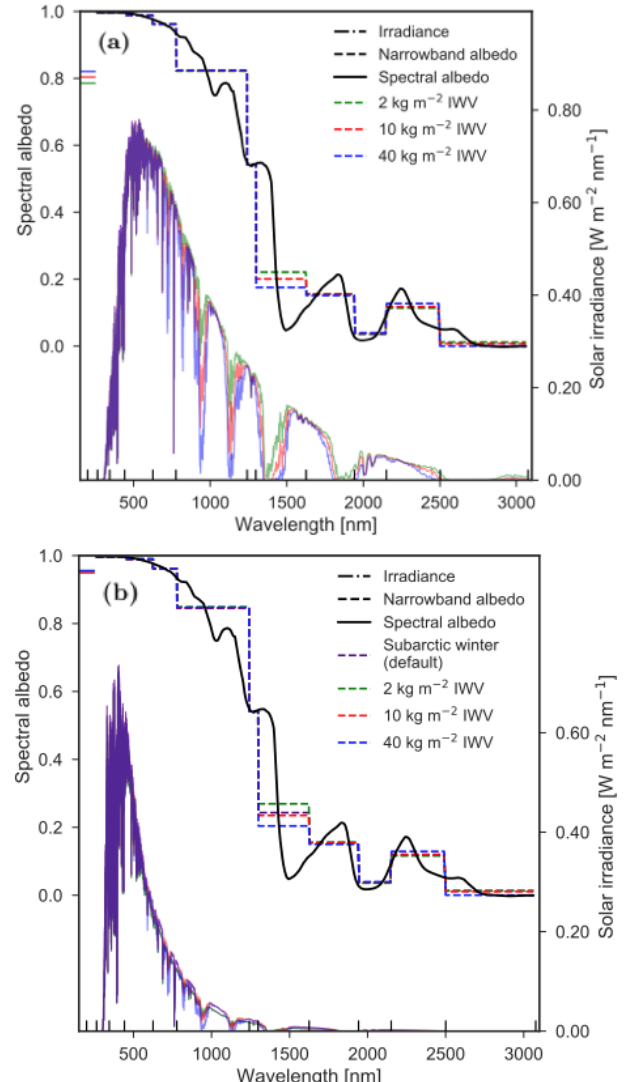
Figure 4. Irradiance and albedo as a function of wavelength for clear-sky conditions for various IWV values for (a) direct and (b) diffuse radiation for SZA=53 ◦ . The albedo is derived by TARTES for a fresh snow layer and the irradiance by DISORT. The narrowband albedo for each of the first 12 spectral bands of RACMO2 is indicated by the dashed line. The vertical black lines on the x axis indicate the spectral band edges of RACMO2. The horizontal colored lines on the y axis indicate the weighted broad- band albedo. The water vapor is distributed vertically in the same manner as the default subarctic winter, which has a IWV of approx- imately 4kgm − 2 .